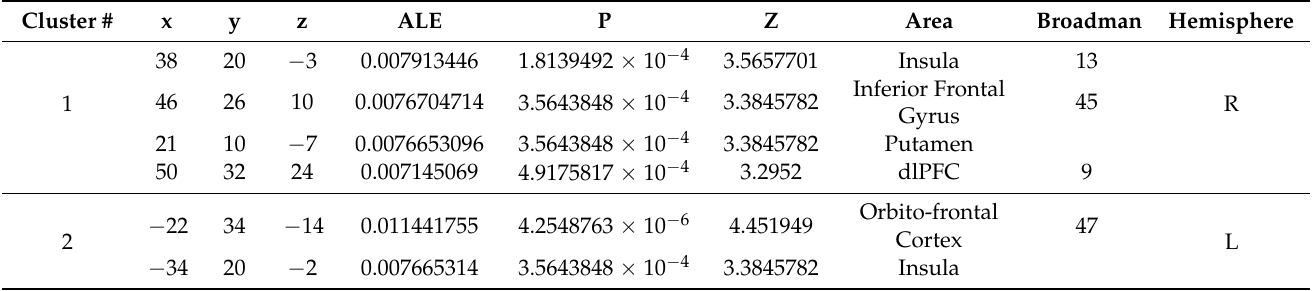
Table 2. Clusters and